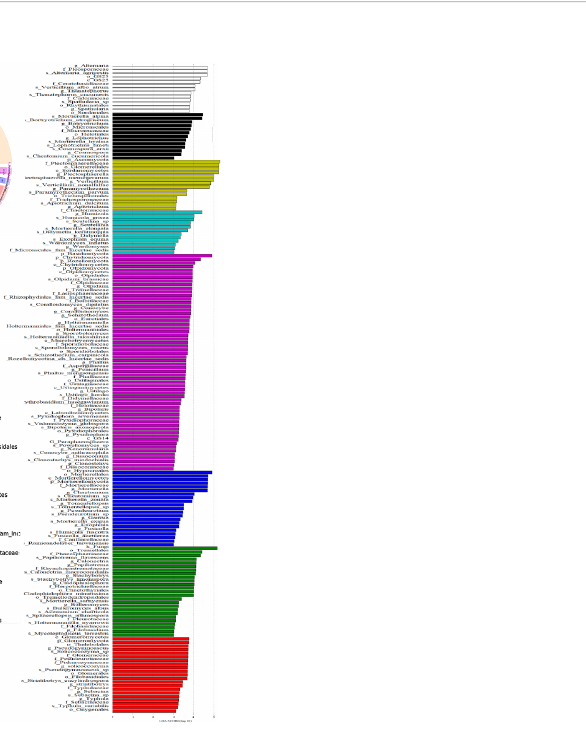
FIGURE 5 LEfSe analysis of soil fungal community structure at different taxonomic levels among different rotation systems (LDA ≥ 3.0). The left fi gure is the cladogram of microbial communities. The right graph is the signi fi cant different taxa among treatments with LDA ≥ 3. B_51, O_51, PC_51 and PR_51 indicate the samples from B, O, PC and PR treatments at pre-planting, respectively; B_910, O_910, PC_910 and PR_910 indicate the samples from B, O, PC and PR treatments at